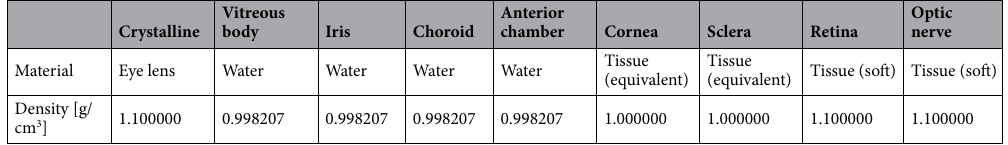
Table 1. MCNP6 materials assigned to the